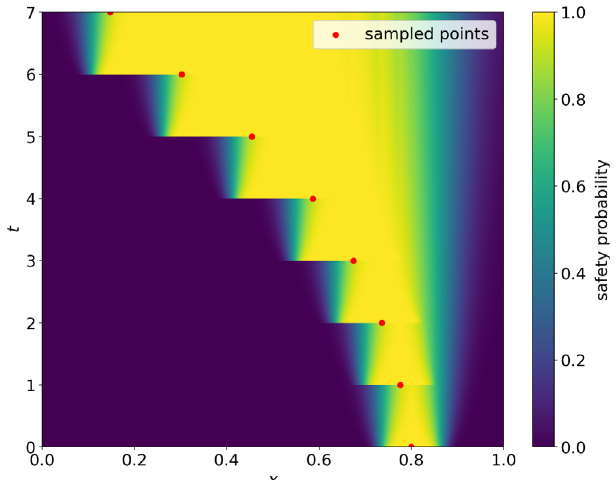
FIG. 6. Evolution of the safety probability during a safety exploration on the drifting 1D test problem. The red dot denotes the time and position of the corresponding sampled point. The safety probability is calculated with the Gaussian random walk drift